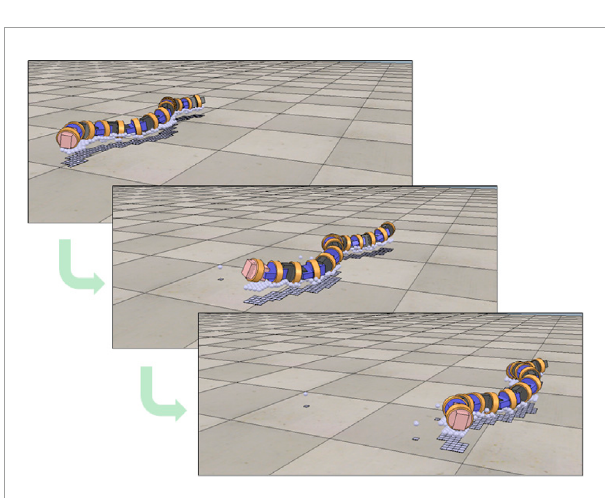
FIGURE 5 Generating the soft floor only in the vicinity of the snake